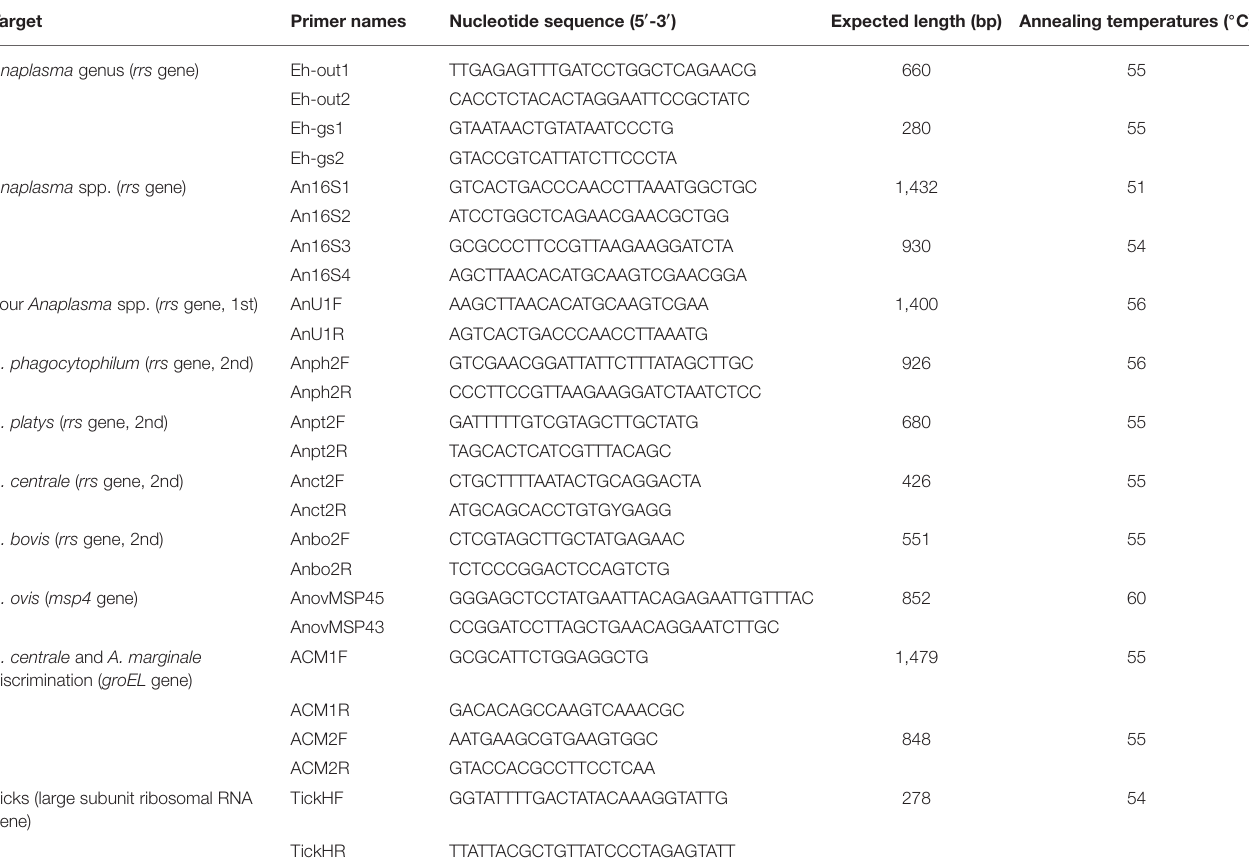
TABLE 1 | Primers used for PCR amplification in the present